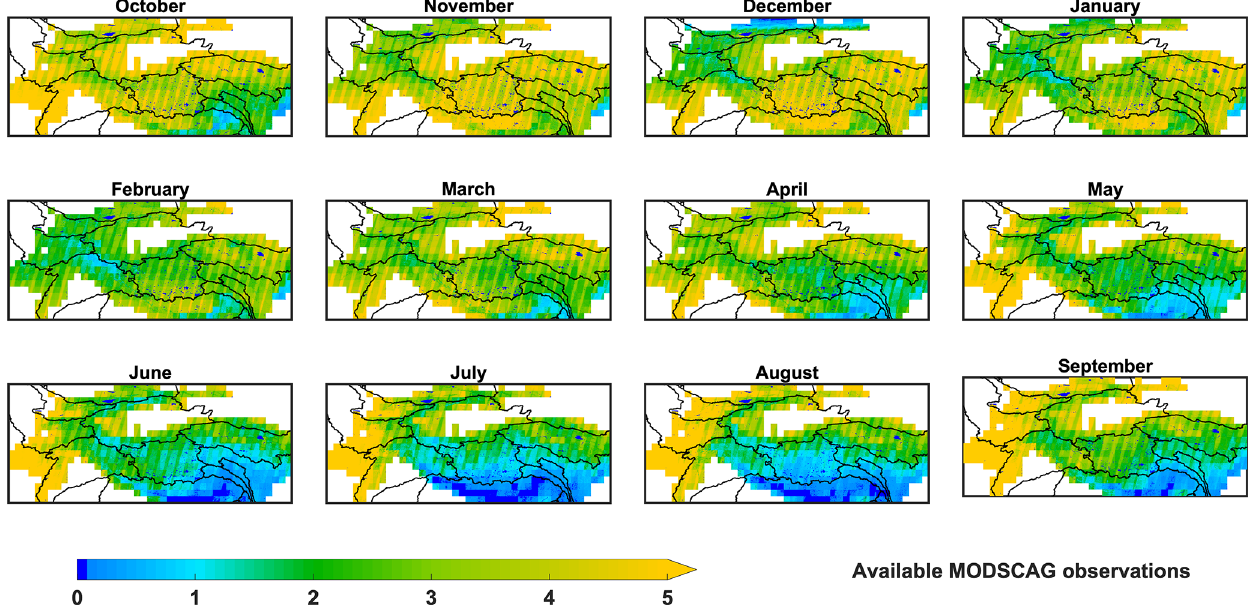
Figure 2. Monthly total number of available (near-nadir) MODSCAG measurements averaged over 18 years, with cloud and viewing angle screening. Landsat measurements supplement these MODIS-derived measurements. The dark blue color is used to distinguish pixels with zero MODSCAG